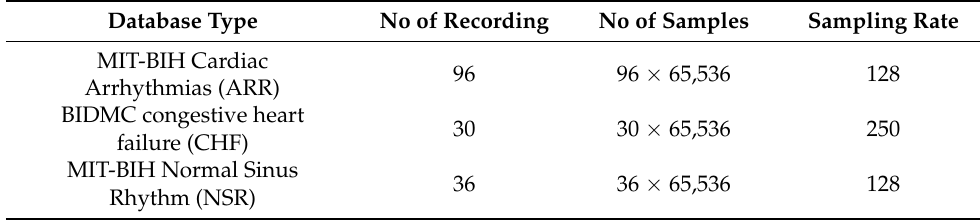
Table 1. Description of all arrhythmia databases from Physionet.